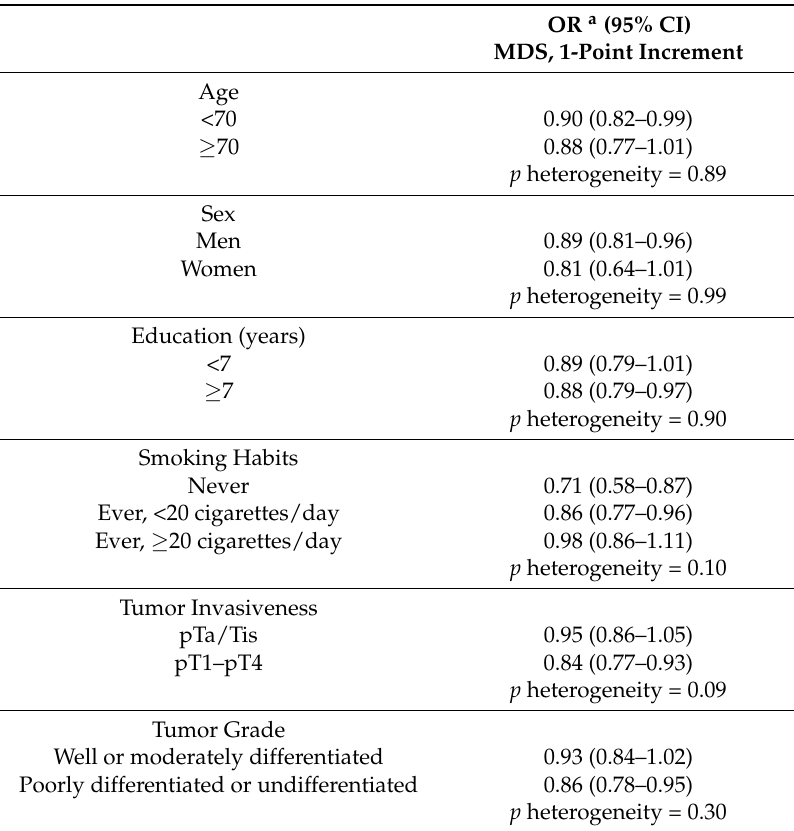
Table 3. OR and 95% CI of bladder cancer for 1 point increment in the MDS in strata of selected factors and according to tumor invasiveness and tumor grade. Italy,